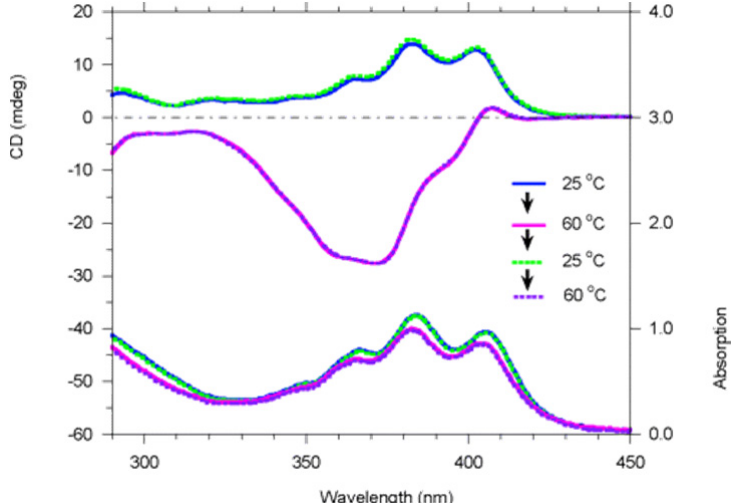
Figure 20. Variable-temperature CD (top) and UV-visible (bottom) spectra of polymer 9 in toluene ( c = 2.1 × 10 − 4 M, path length = 1 cm) in the heating-cooling-heating thermal cycle [70]. Reproduced by permission of the American Chemical